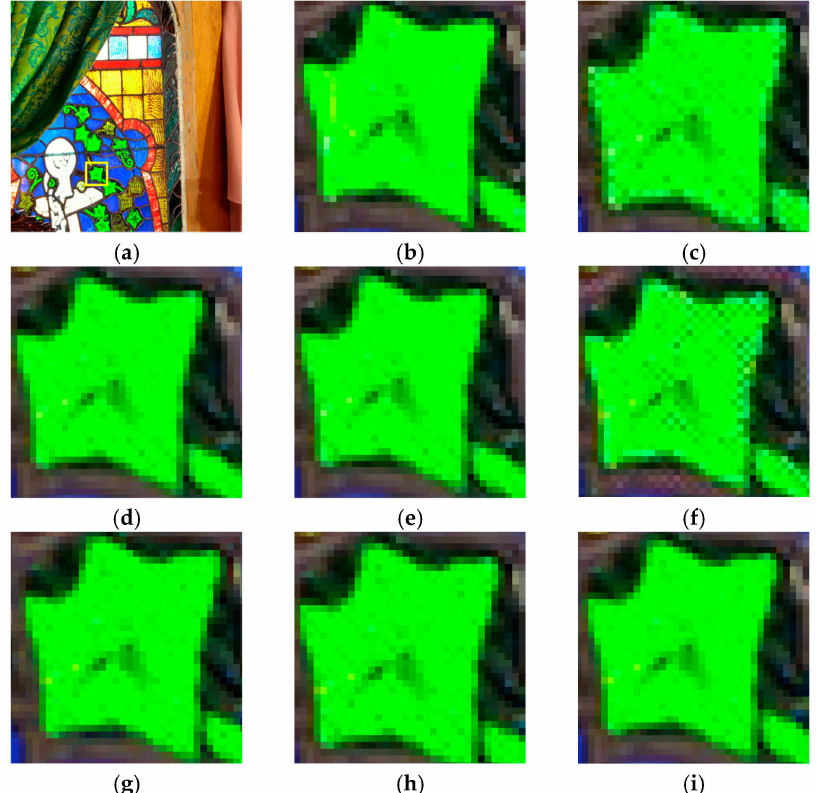
Figure 7. The processing results of image Figure 6a: ( a ) the original image marked with the yellow rectangular frame; ( b ) the enlarged area of the yellow rectangular frame; ( c ) DLMMSE [9]; ( d ) LDI-NAT [29]; ( e ) LDI-NLM [29]; ( f ) VDI [18]; ( g ) RI [19]; ( h ) MLRI [21]; ( i ) the proposed algorithm.